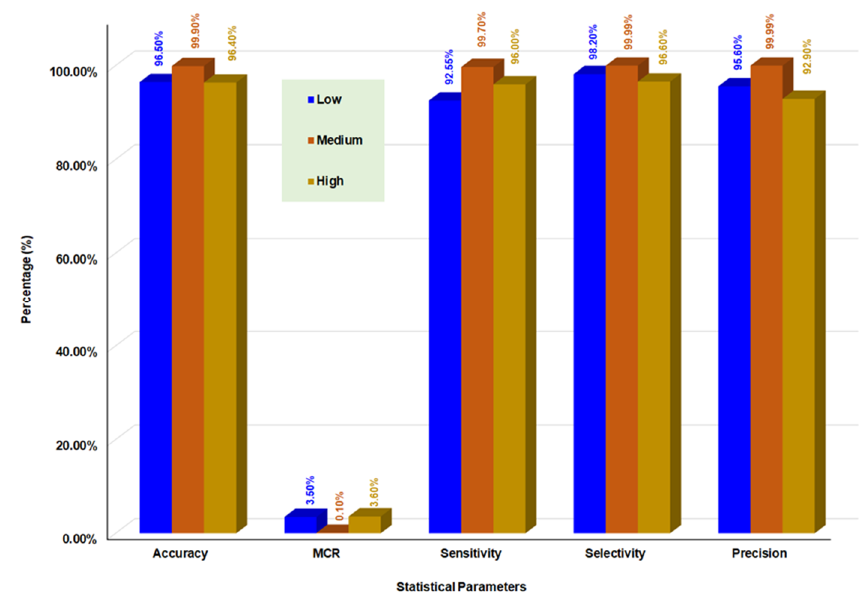
Figure 3. Statistical parameters for low, medium and high classes.